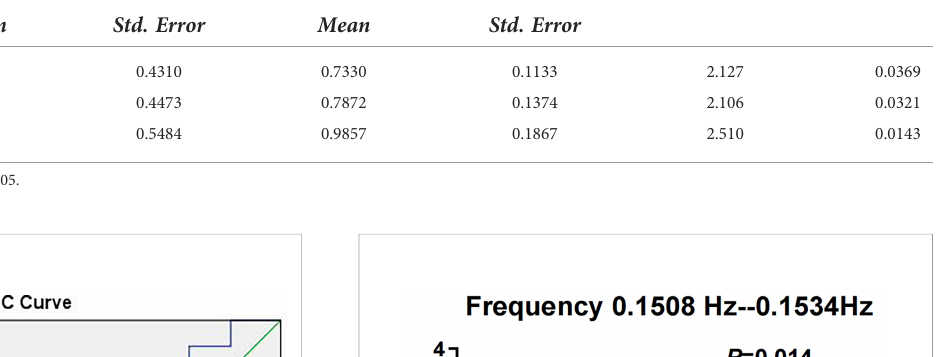
TABLE 2 Three frequency points possess statistical signi fi cance in comparing the difference fl uctuation power between the malignant and benign tumors in all frequency points (sum of 96 points). Freq. points